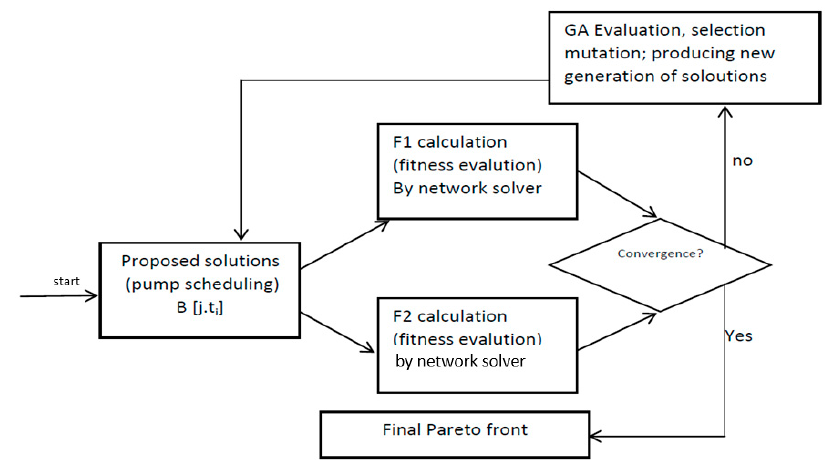
Figure 2. Multi-objective optimization process to find final Pareto front.